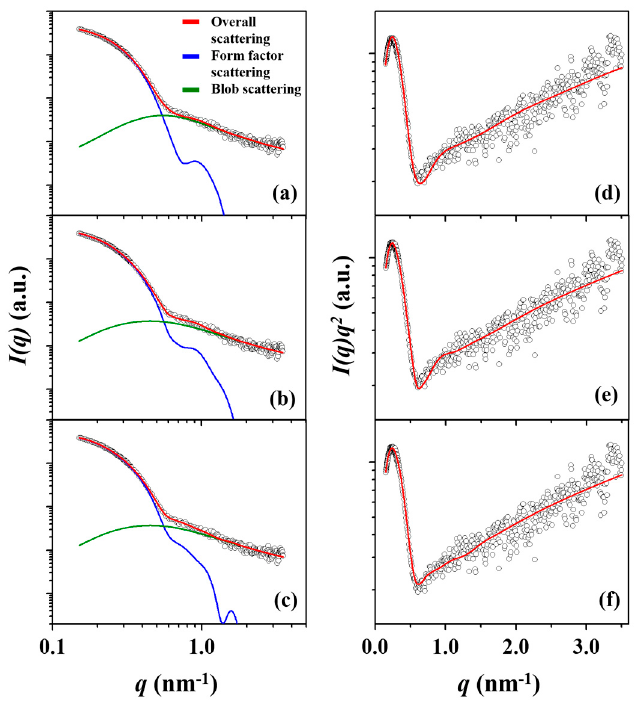
Table 2. Structural parameters of the l -PBA- b -PEO micelle obtained from the quantitative analysis of scattering data with various model approaches.